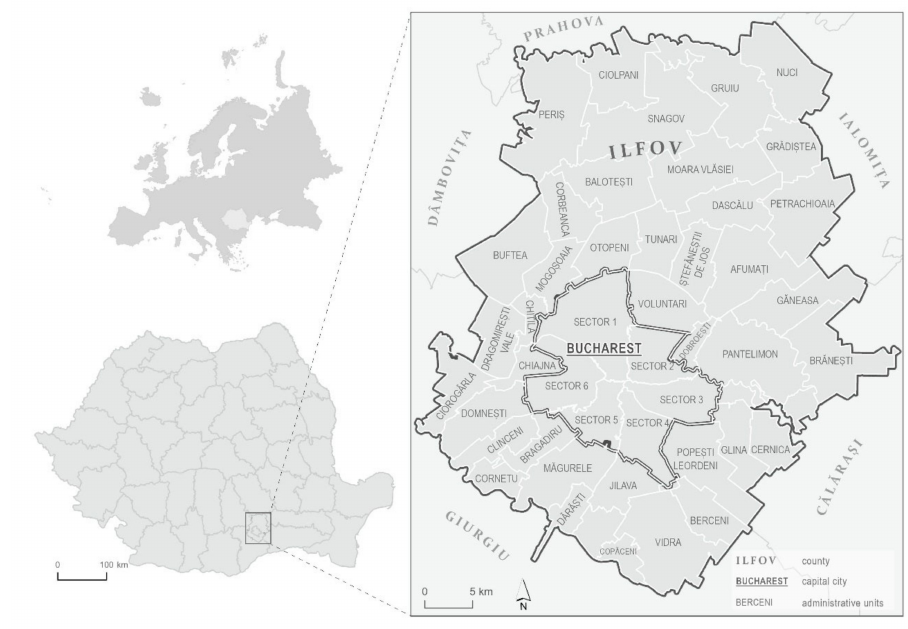
Figure 1. Location map of the study